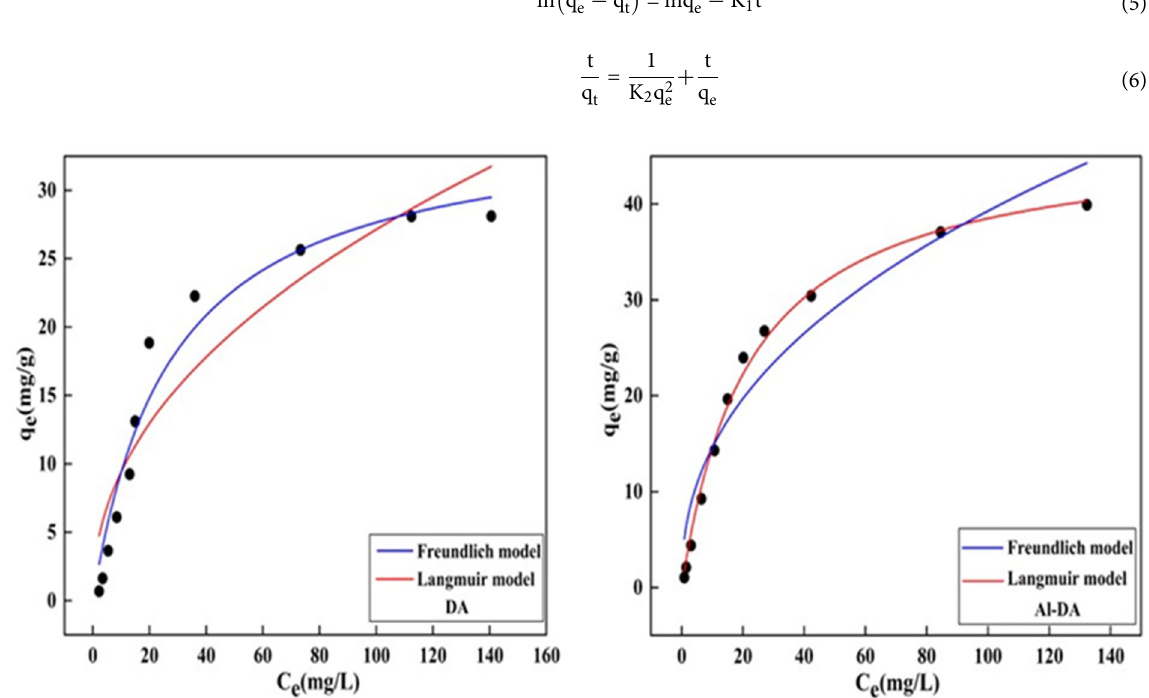
Figure 6. Adsorption isotherms of DA and Al-DA (pH 6, contact time 2 h, Sorbent dose 4 g/L).